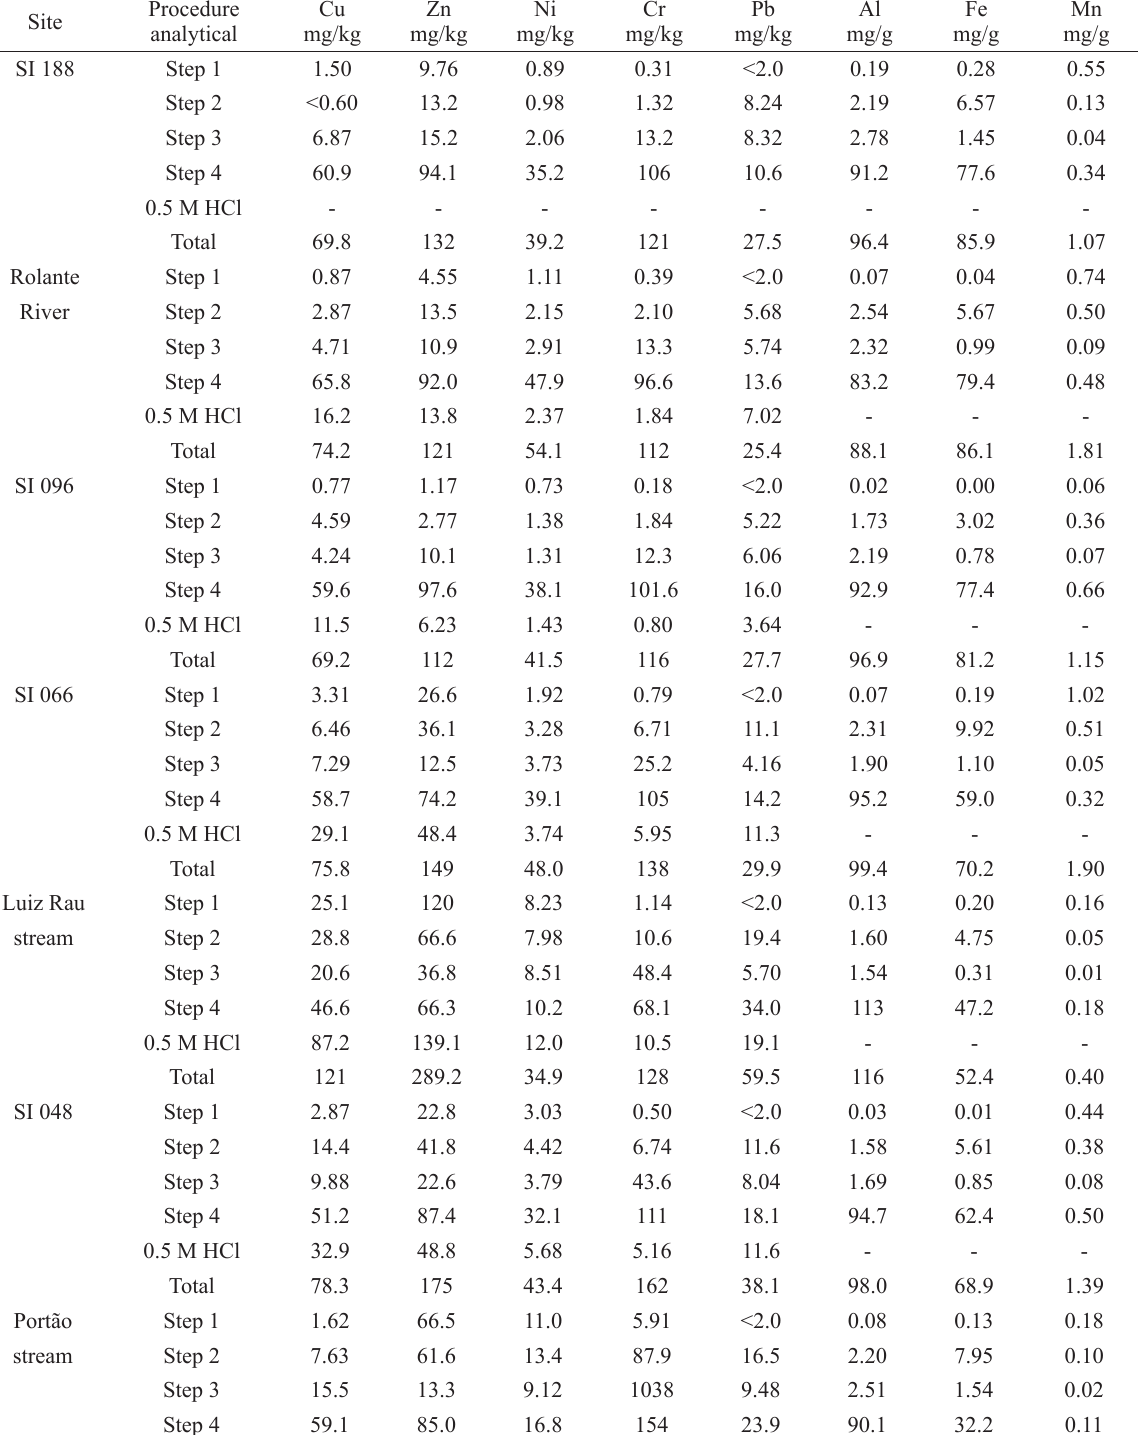
Metals concentrations for the sequential extraction procedure BCR, extraction with 0.5 mol/L HCl and total contents with